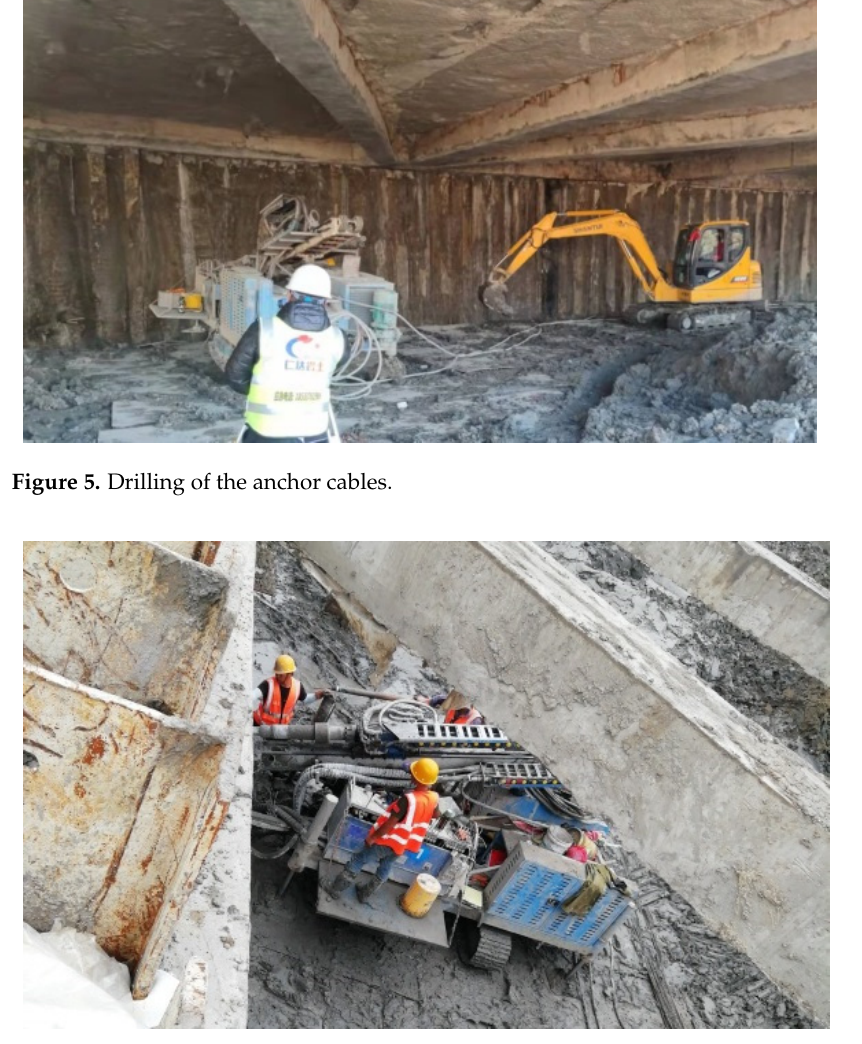
Figure 6. Grouting of anchor